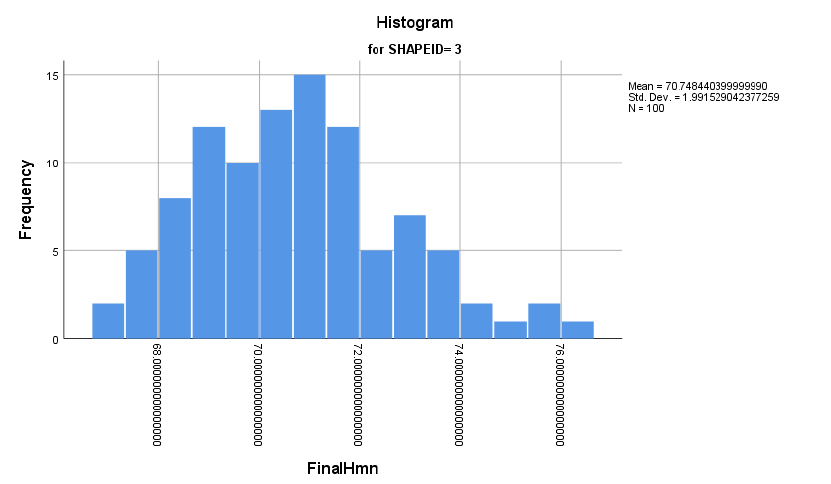
Figure A7. Shrink height adjustment for 70 mm.